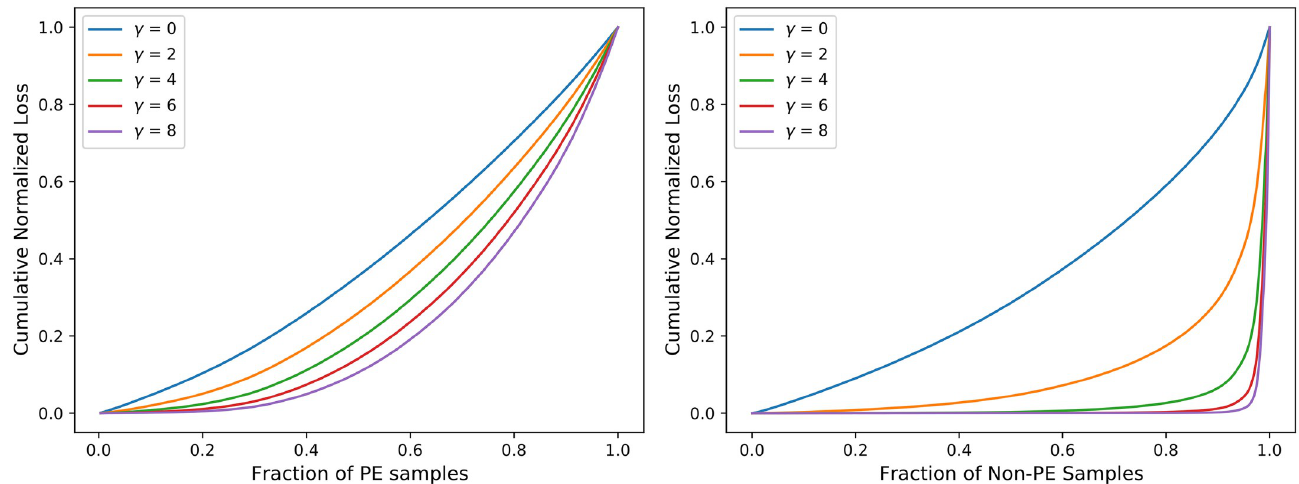
Fig 20. Cumulative distribution functions of the normalized loss for PE (positive) and Non-PE (negative) samples for various γ values and α = 0.5 for MOMI data.